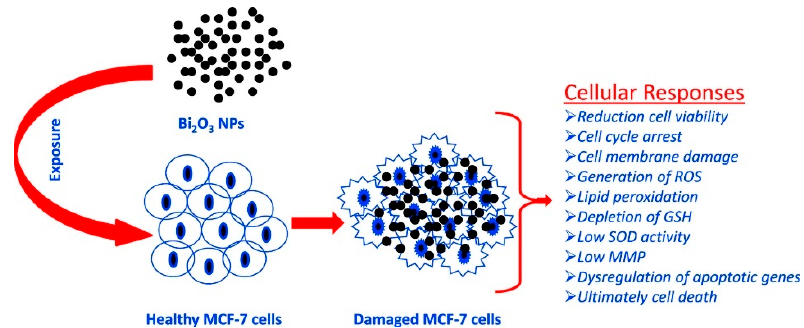
Figure 4. Summary of the process of oxidative stress induced by Bi 2 O 3 in MCF-7. Picture is reprinted with permission from Ahamed et al. [64] .